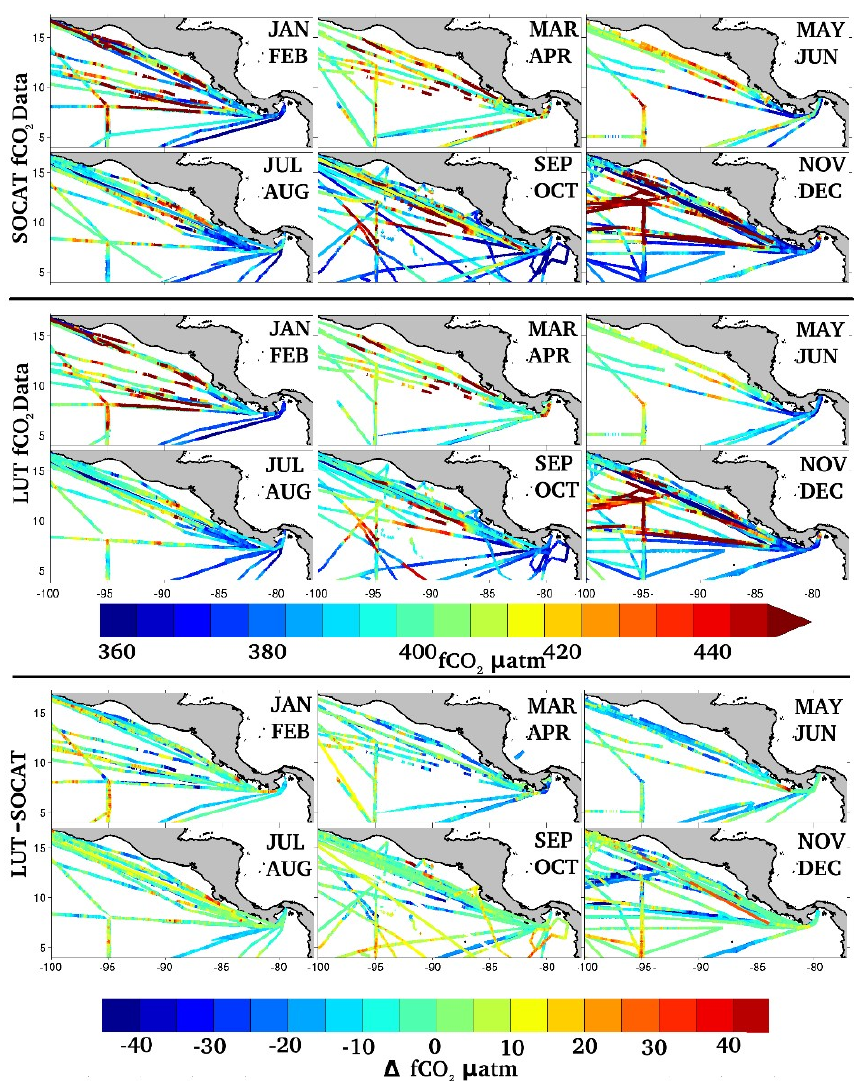
Figure 6. SOCAT f CO 2 bimonthly (January + February, March + April, May + June, July + August, September + October, November + December) observations within the ETPO corrected for the annual CO 2 increase, LUT-derived bimonthly f CO 2 calcu- lated using SOCAT SST and SSS observations and LUT SOCAT